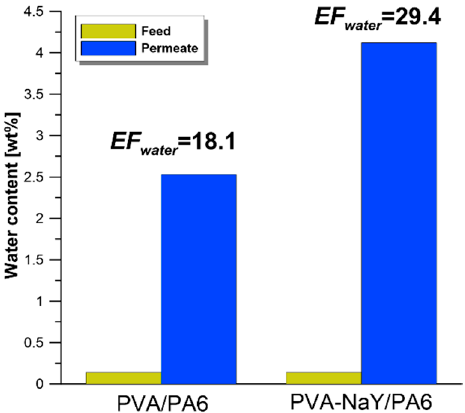
Figure 12. Comparison of enrichment factor of water obtained during the separation of EtOH/ETBE mixture containing 20 wt % of EtOH.